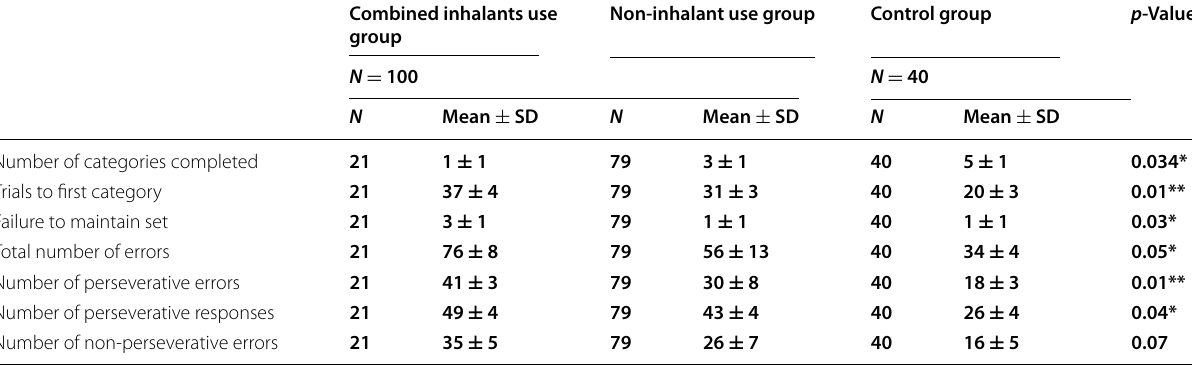
* p -value < 0.05 significance. ** p -value < 0.01 significance. Shows that combined inhalant use group shows lower mean than control group, non-inhalant use group as regard number of category completed, and the difference had statistically critical p 0.034. Combined inhalant use group shows higher mean than control, = non-inhalants use groups as regard trial to first category, failure to maintain set, total number of errors, number of perseverative errors, and number of perseverative responses; the difference had statistically critical p 0.05, which mean that inhalants use impairs early conceptualization, sustained attention, and flexibility domains. = Combined inhalant use group shows higher mean than control, non-inhalants use groups as regard number of non-perseverative errors, but the difference had